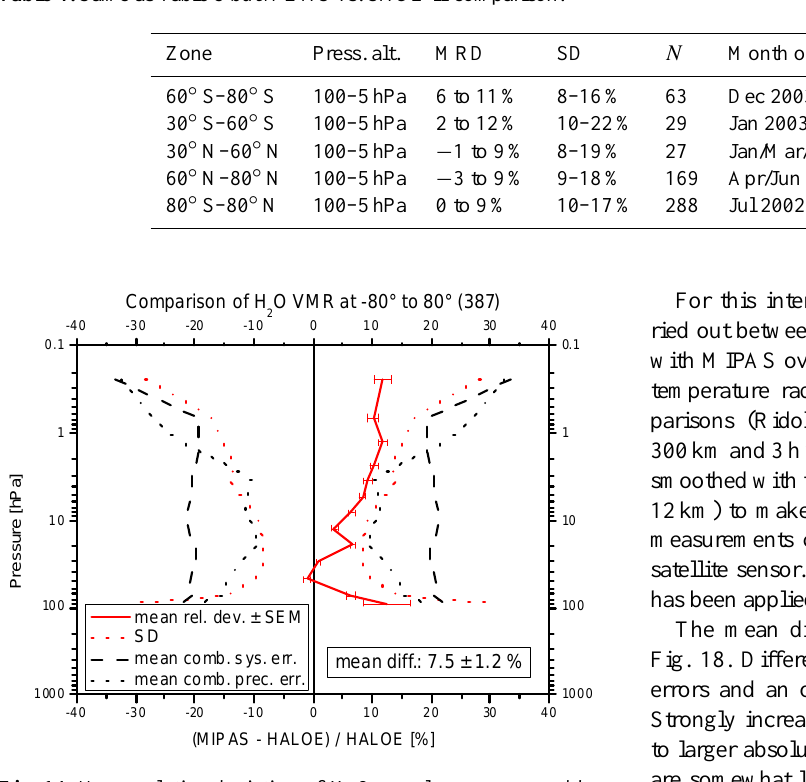
Table 4. Same as Table 3 but MIPAS vs. SAGE-II comparison.